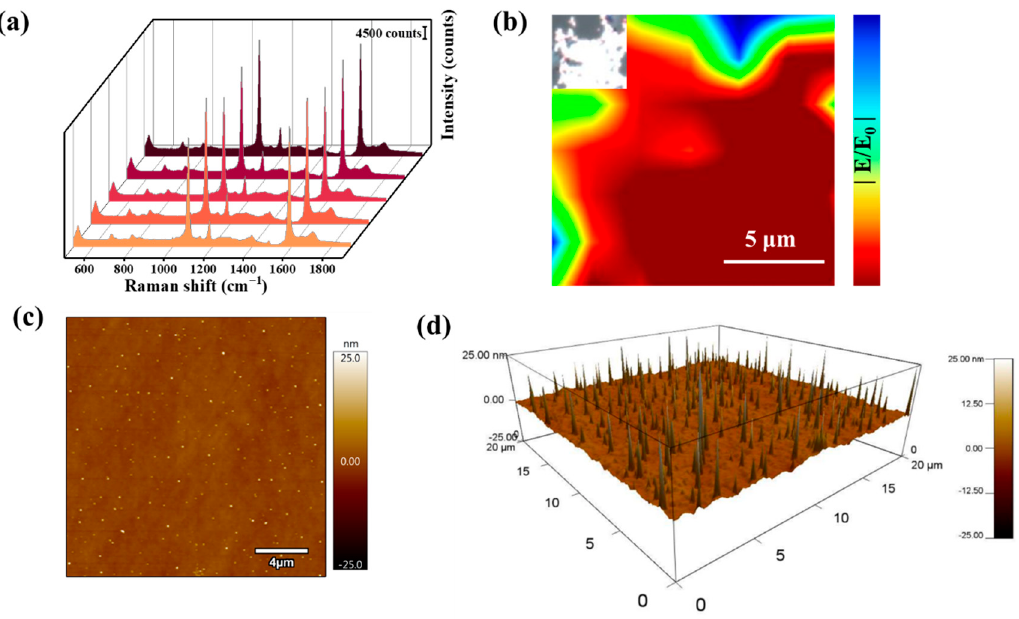
Figure 4. ( a ) 3D Raman spectra of Au@Ag; ( b ) 2D Raman imaging of Au@Ag (inset is the optical image of Au@Ag); AFM images of ( c ) 2D mode and ( d ) 3D mode of Au@Ag.